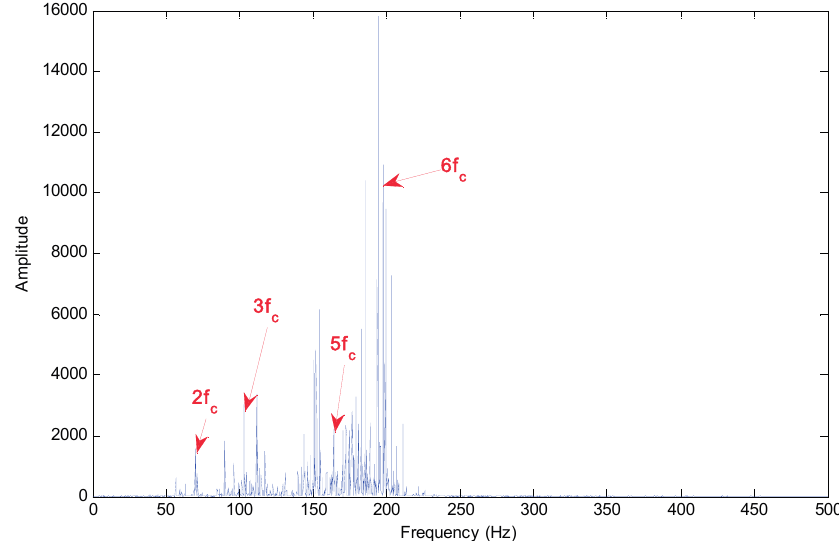
Figure 13. Hilbert marginal spectrum of selected IMFs for axle bearing vibrations with pin roller